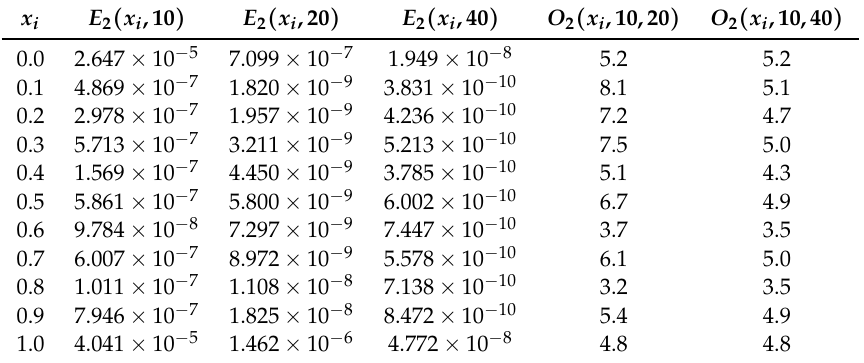
Table 4. The absolute errors of the second order derivatives of y 1 at the knots and the numerical convergence orders.